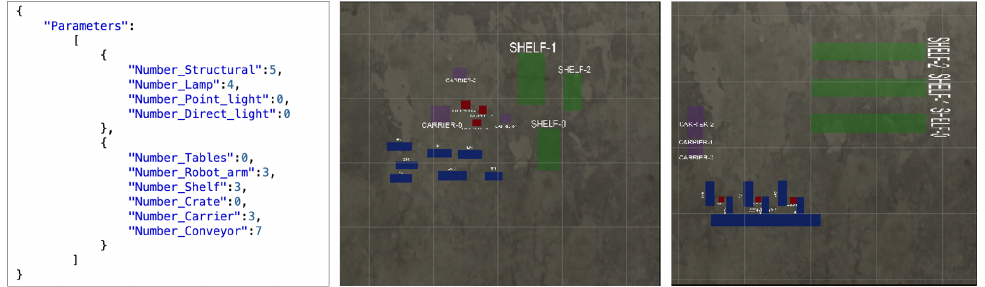
Figure 12. Structured description of the desired scene ( left ) and 2D map with default ( middle ) and desired ( right ) positioning of elements for case no.1. Elements can be moved around the scene and resized either through JSON description or Unity interface.